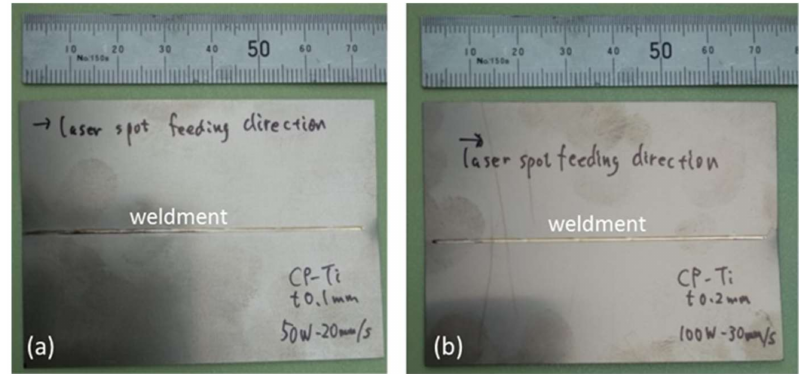
Figure 3. Welded CP Ti foils: ( a ) 100 µ m thick and ( b ) 200 µ m thick.